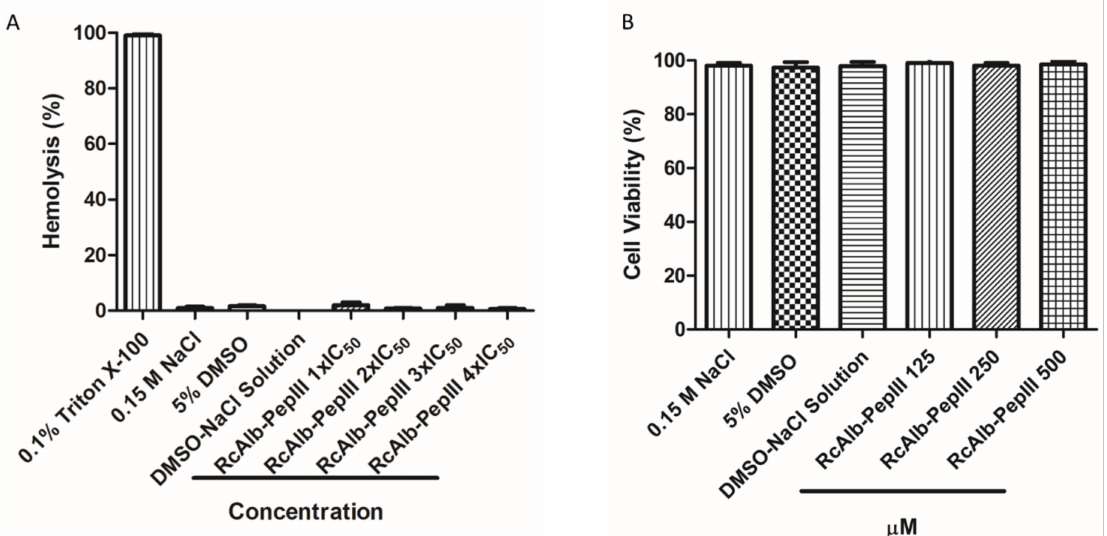
Figure 7. Hemolytic and toxic potential of RcAlb -PepIII. ( A ) Hemolytic action of RcAlb -PepIII on rabbit red blood cells. It is possible to see no hemolysis even at concentration three times higher than the IC 50 concentration against H. contortus . ( B ) Effect of RcAlb -PepII on Vero cells at 500 µ M concentration 5.5 times higher than the RcAlb -PepIII IC 50 toward H. contortus. Data were expressed as the mean ± standard deviation of three independent experiments. Different letters indicate significant differences between treatments ( p <